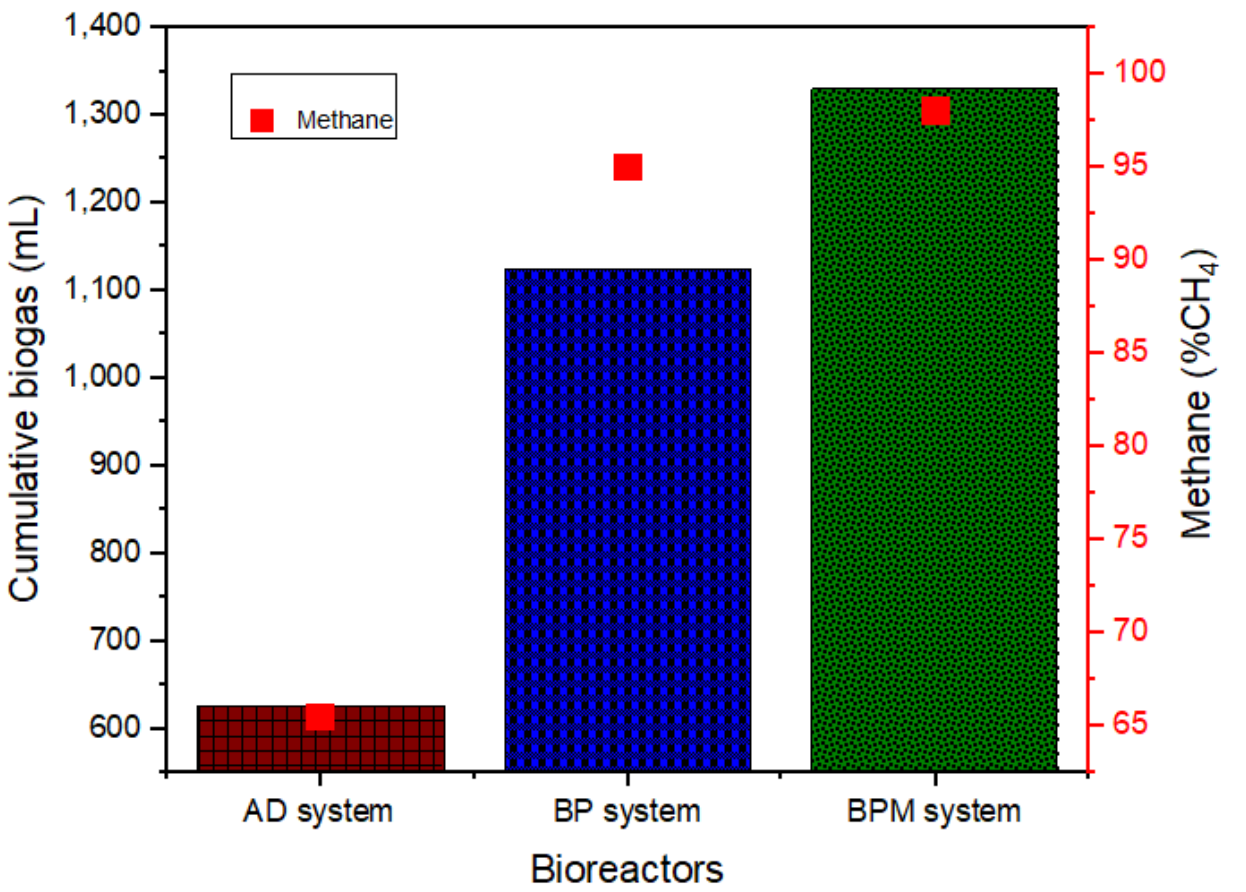
Figure 5. Bioreactor maximum cumulative biogas yield (mL) and methane composition (% CH 4 ) after 30 days of incubation.